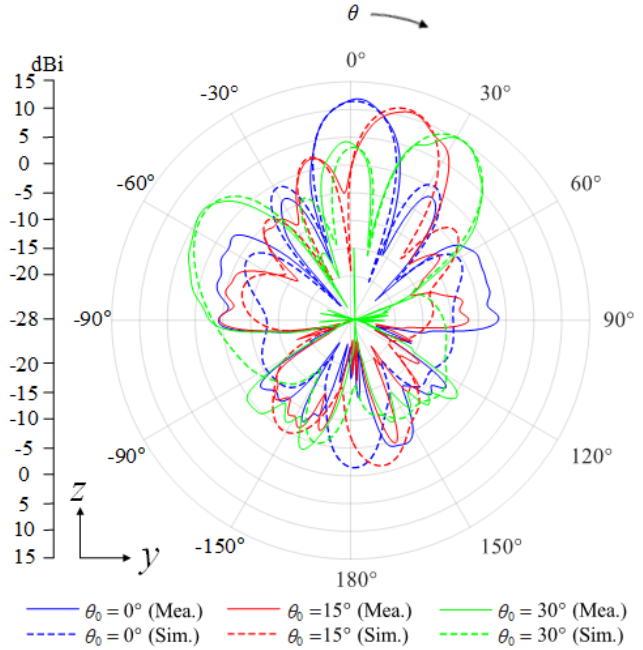
Figure 7. Simulated and measured peak gains at different beam-steering angles.